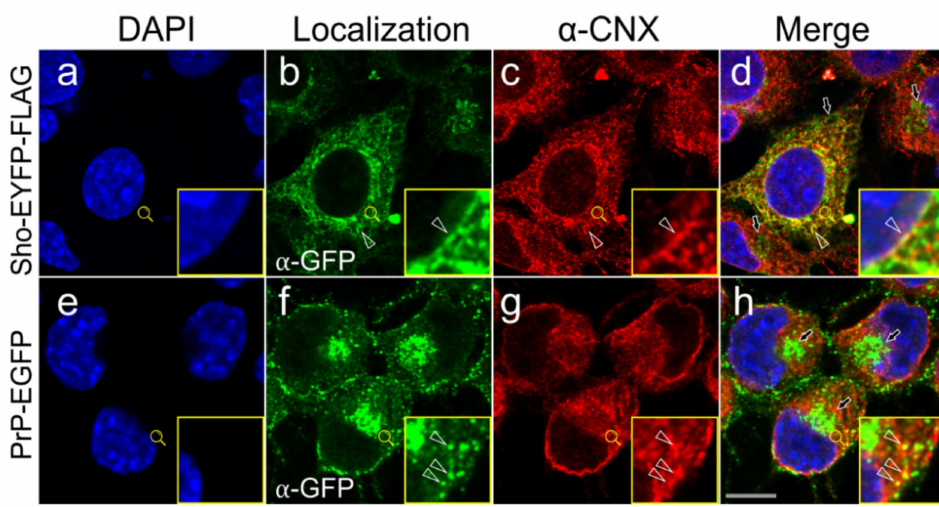
Figure 4. Subcellular localizations of Shadoo, the prion protein and calnexin partially overlap, as detected by immunocytochemistry. Representative immunocytochemistry and confocal microscopy images of stable transgenic Shadoo (Sho-EYFP-FLAG) and prion protein (PrP-EGFP)-expressing cells. Nuclei are stained by DAPI ( a , e ). Alexa Fluor 488-labeled secondary antibody is used to detect the primary antibody against EGFP/EYFP (( b , f ); green). Alexa Fluor 568-labeled secondary antibody is used to detect the primary antibody against calnexin, α -CNX (( c , g ); red). Yellow pixels indicate colocalization of Sho or PrP with CNX on the merged images presented in the last column ( d , h ). Insets correspond to the areas marked by magnifying glass symbols and highlight representative ER areas for better visualization. Arrowheads mark examples of colocalization areas, whereas arrows point to the Golgi apparatus. Scale bar: 10 µ